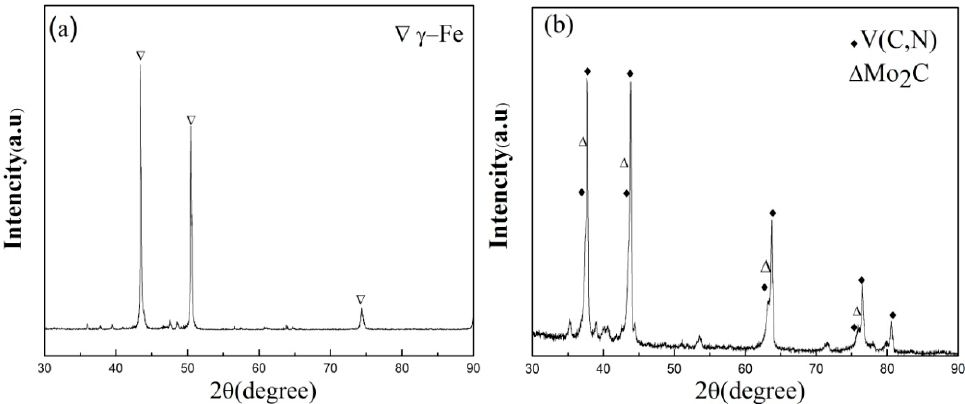
Figure 6. XRD patterns of steel block and precipitates powder: ( a ) steel block after etching of as ‐ cast ESR ingot; ( b ) precipitate powders that were electrolytically extracted from as ‐ cast ESR ingot.